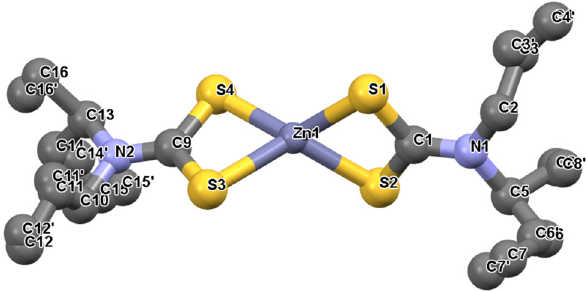
Figure 5: Molecular structure of the [ Zn ( II ) bis ( N - ethyl - N - phenyl dithiocarbamate ] complex. Redrawn from ref. [ 42 ] , with permission from “ Taylor and Francis ” ( Copyright 2020 ) .